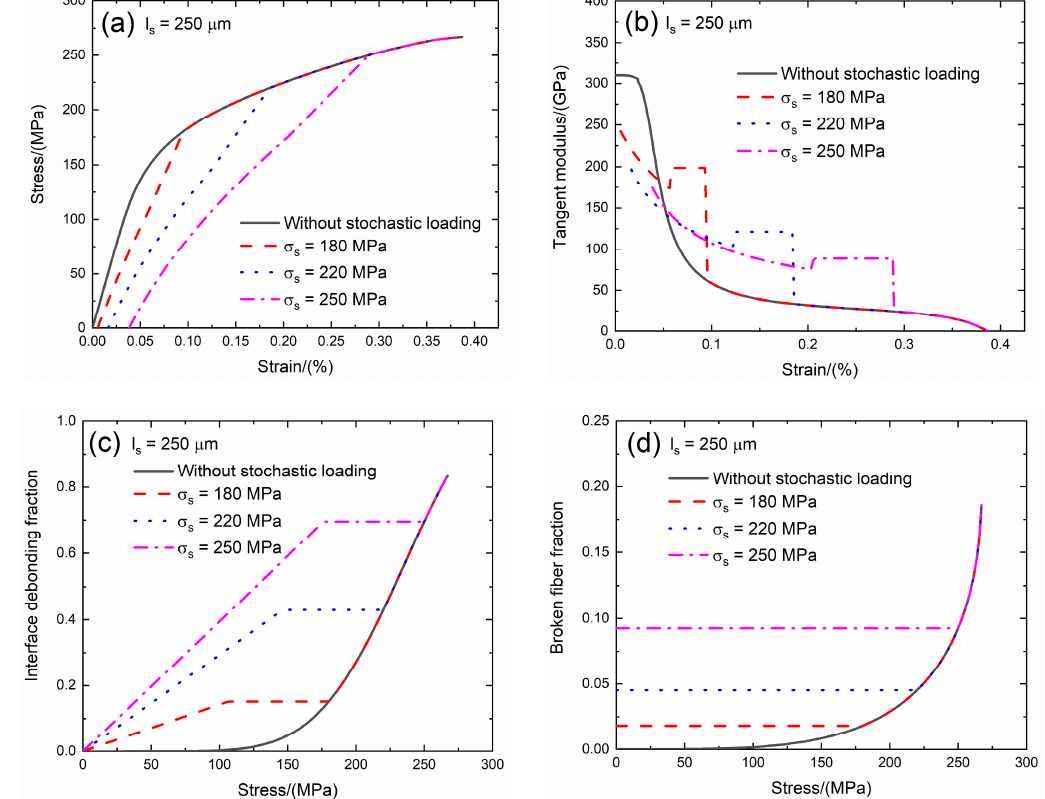
Figure 10. ( a ) The tensile stress–strain curves; ( b ) the tangent modulus versus strain curves; ( c ) the interface debonding fraction versus stress curves; and ( d ) the broken fibers fraction versus stress curves of SiC/SiC composite for conditions without stochastic loading and with stochastic loading of σ s = 180, 220 and 250 MPa when l s = 250 μ m. Table 4. The effect of the saturation matrix crack spacing ( l s = 200 and 250 μ m) on tensile stress–strain curve, tangent modulus, interface debonding fraction and broken fiber fraction of SiC/SiC composite subjected to stochastic loading of σ s = 180, 220 and 250 MPa.